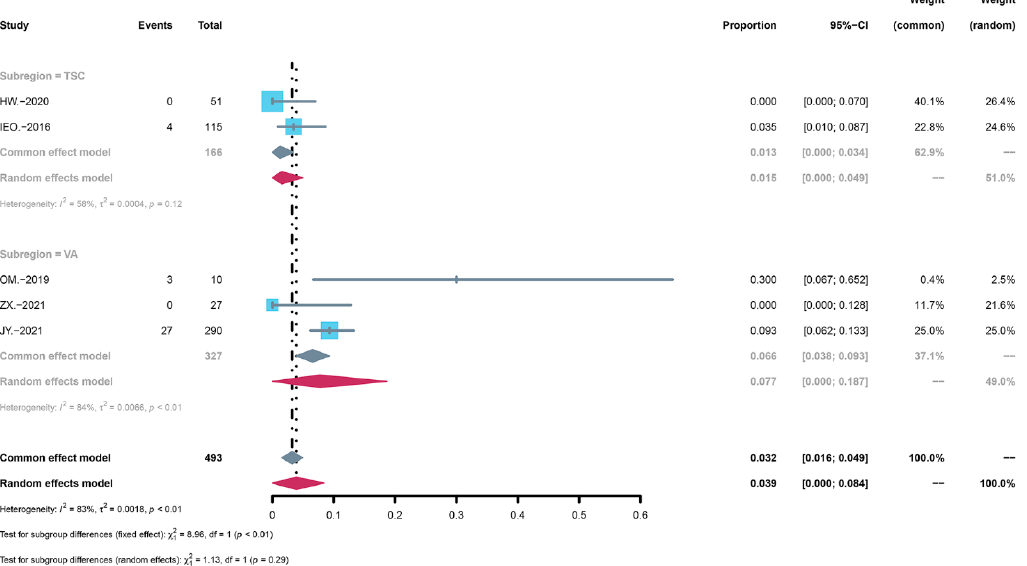
Figure 5. Forest map of the disease subgroup analysis of serious adverse events .